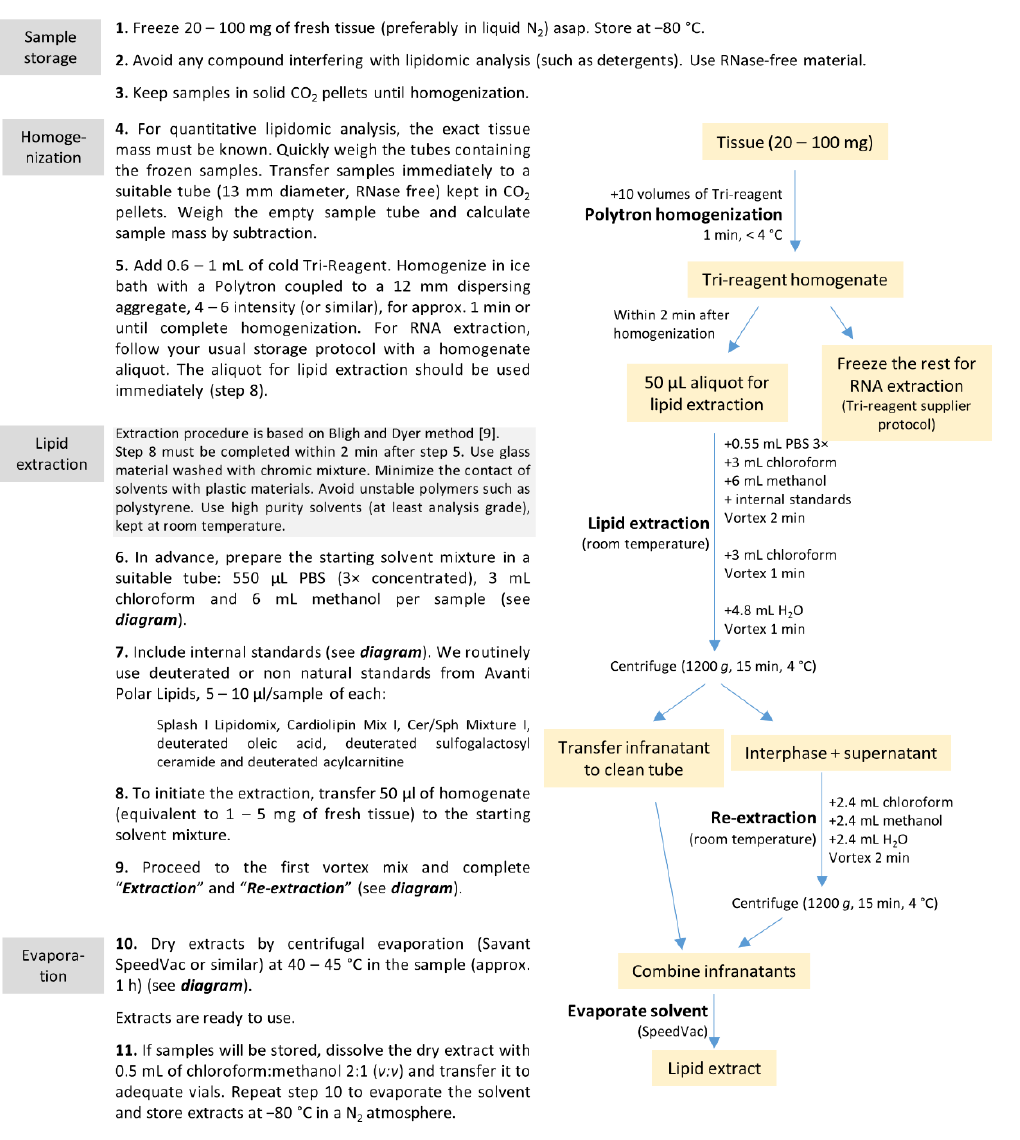
Figure 3. Optimized protocol for sample processing and lipid extraction starting from a tissue piece taken for RNA extraction with Tri-reagent [9].